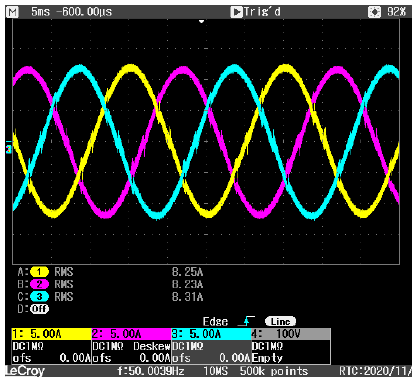
Figure 19. Details of SAPF phase current waveforms at 1 ms/div ( a ) and 500 µs/div ( b ).